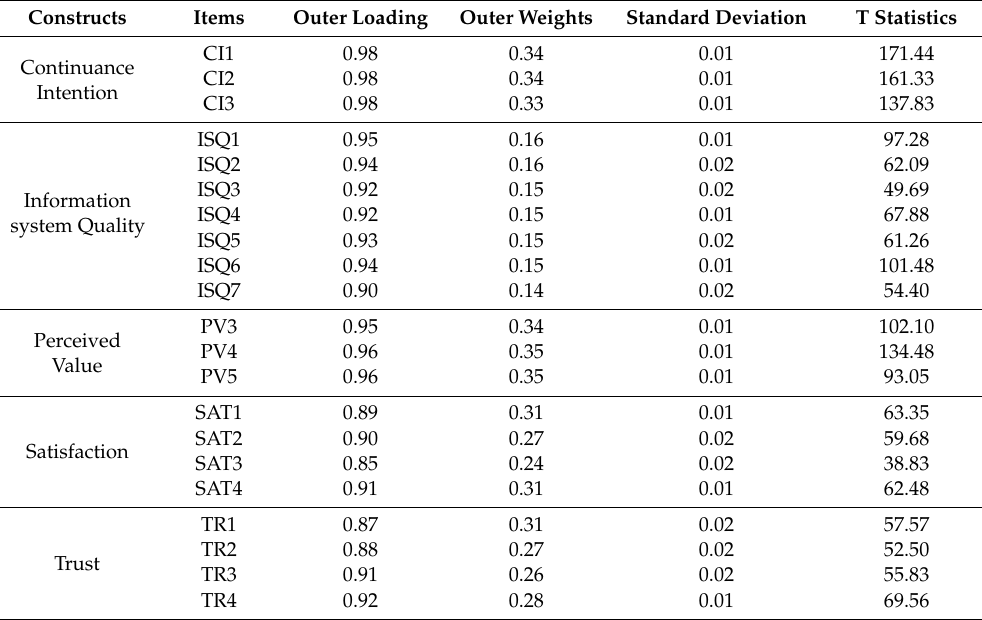
Table 4. Weight and loading.